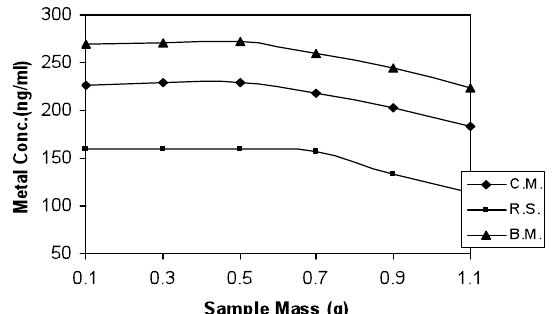
Figure. 3. Effect of the sample mass on the iron recovery from acid solvent with UPM (B.M. = beet molasses, C.M. = cane molasses, R.S. = raw sugar)